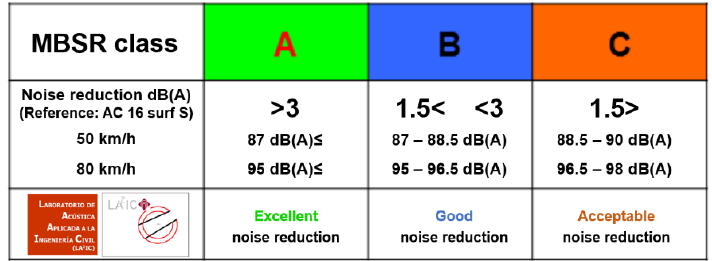
Figure 4. Noise reduction reference values (LNP labeling LA²IC ) for Spanish pavements classified as MBSR Class A, Class B, and Class C (50 and 80 km/h).